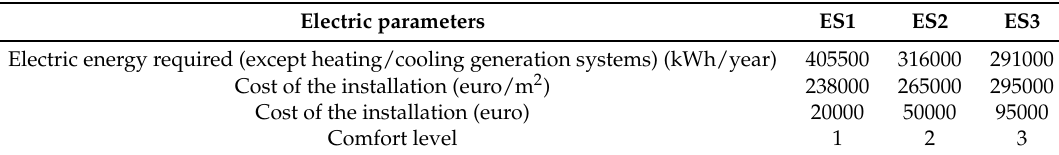
Table A8. Electric parameters—electric system.